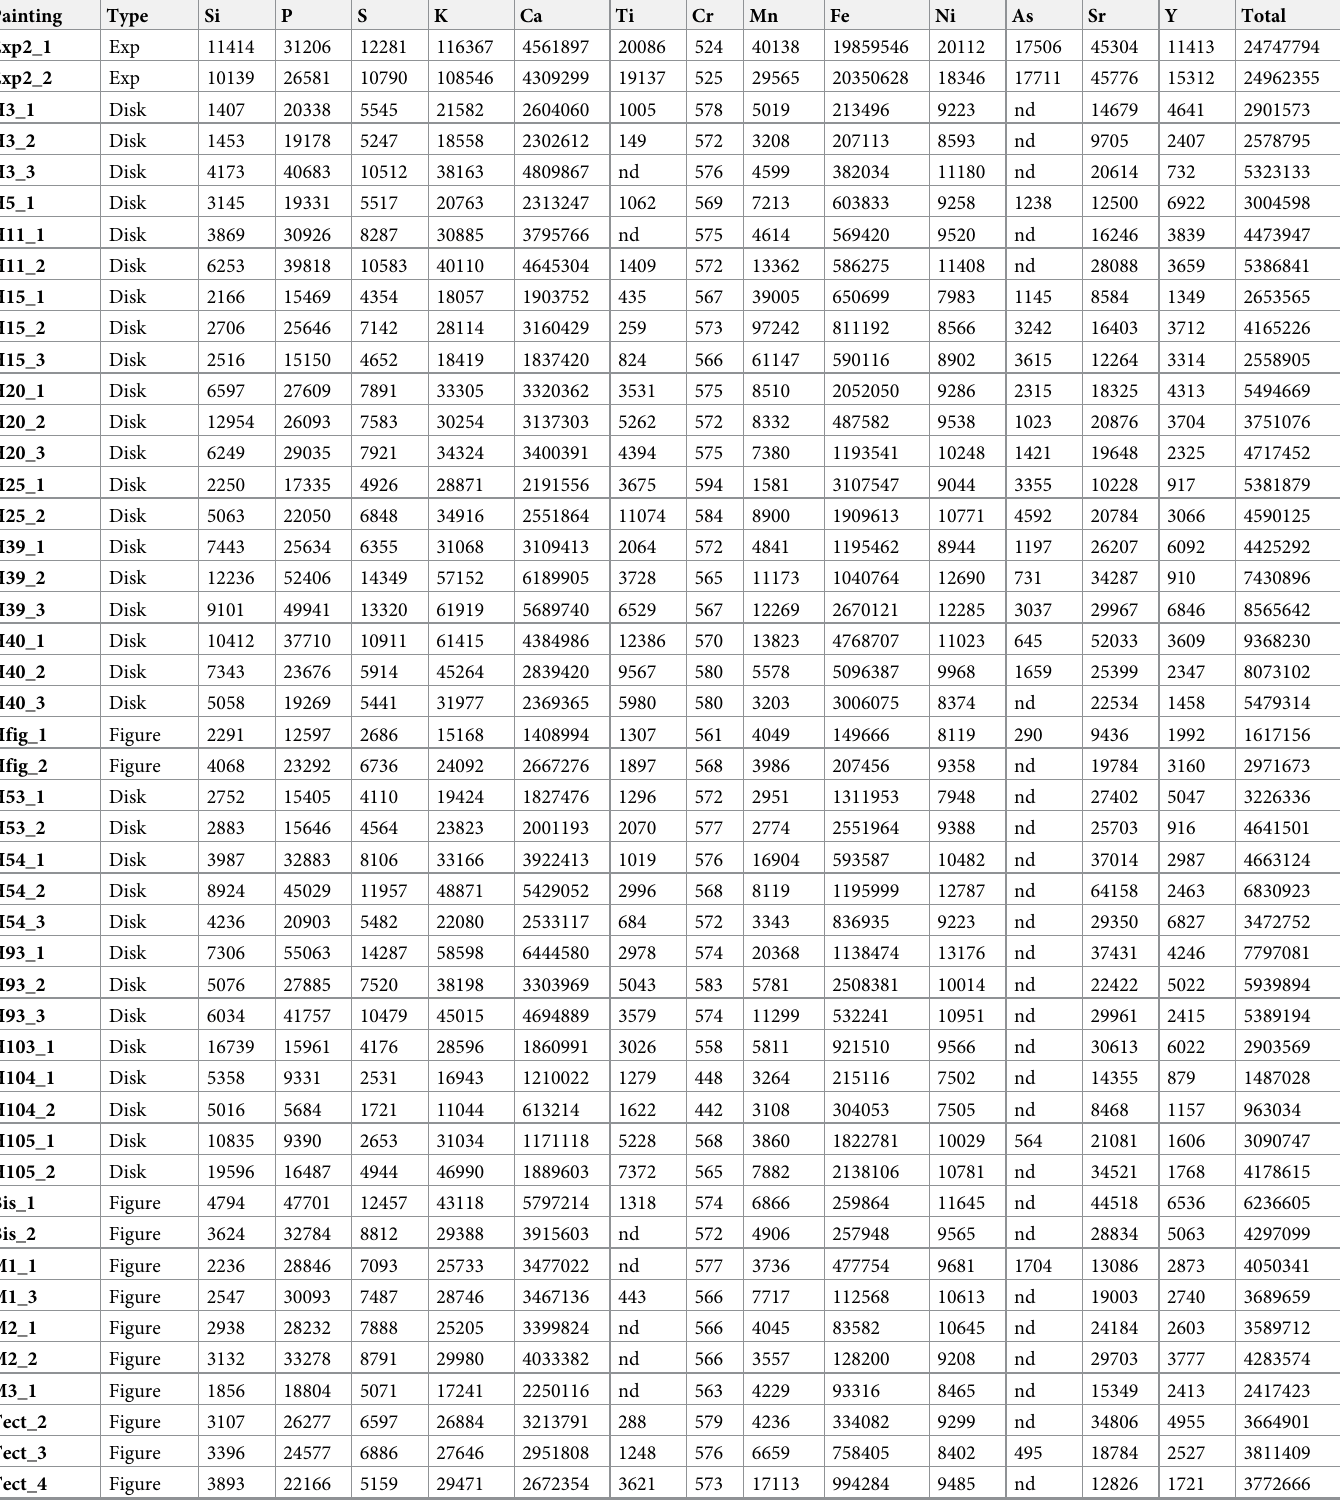
Table 5. Netto counts of elements detected by pXRF, calculated with the fundamental parameters.